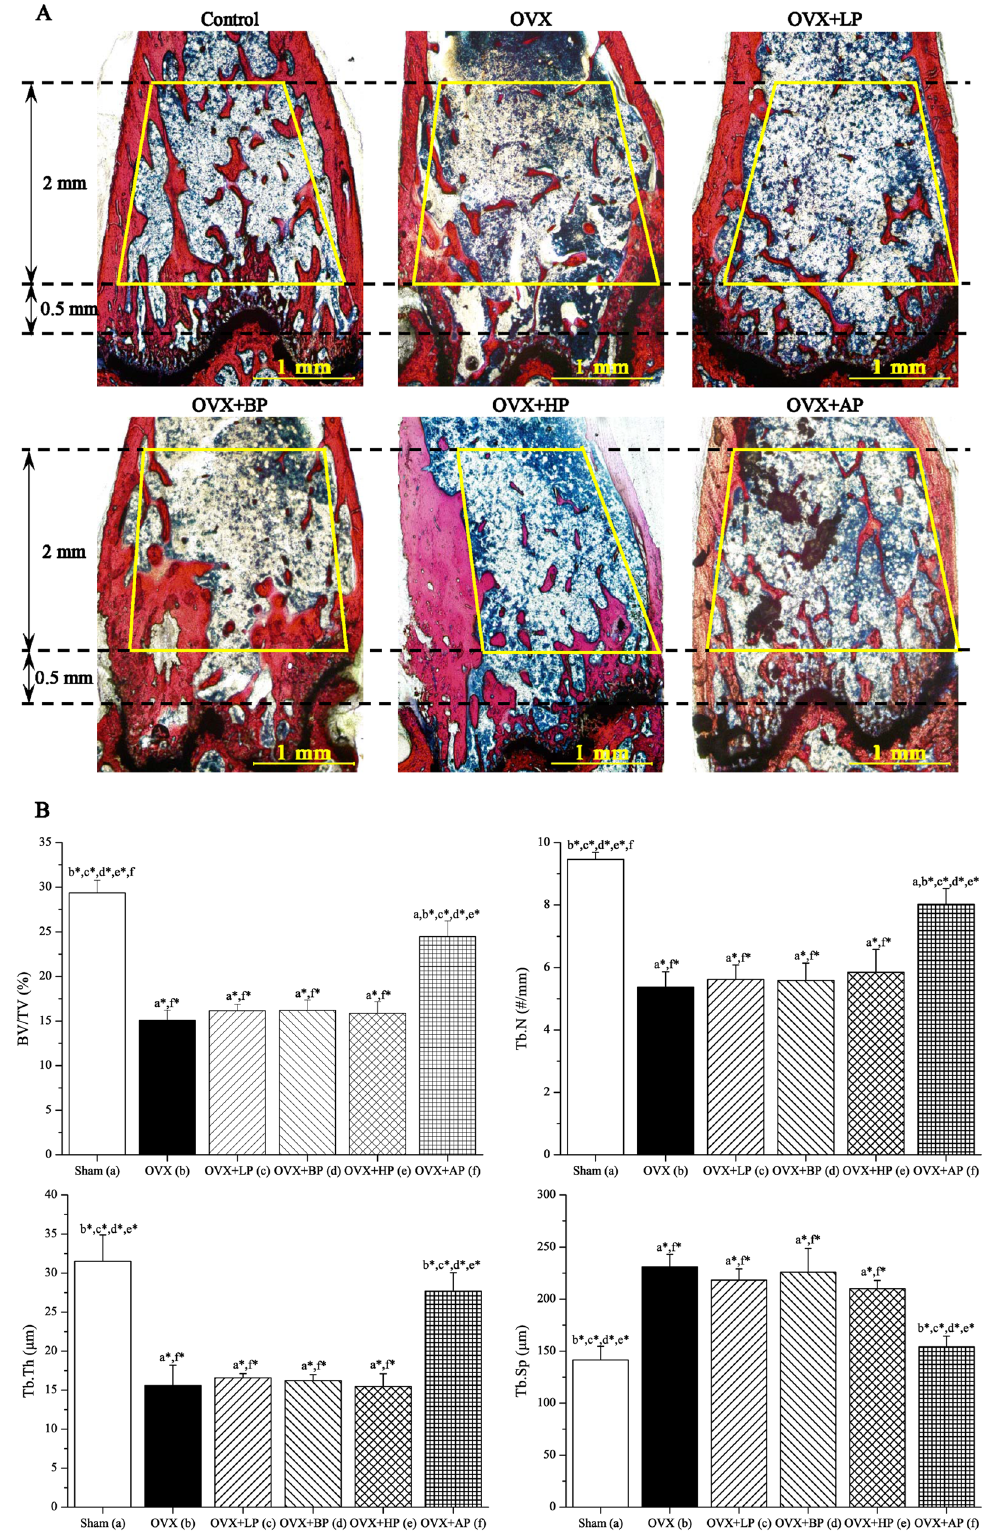
Figure 9. Effects of 8-week EMF exposure on trabecular bone histology and histomorphometry in OVX mice. ( A ) Representative histological images for bone microarchitecture of the distal femora by Van Gieson staining. Scale bar = 1 mm. ( B ) Histomorphometrical analysis of trabecular bone microarchitecture determined by an area of interest (AOI) that was 2 mm long 0.5 mm proximal to the growth plate. Values represent mean ± SD of 8/group. Letters a-f indicate differences between respective groups at P < 0.05 or * P < 0.01 (a versus Sham; b versus OVX; c versus OVX + LP; d versus OVX + BP; e versus OVX + HP; f versus OVX +